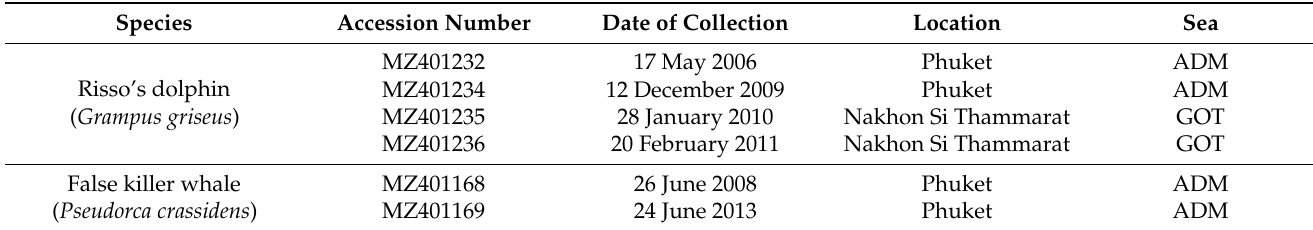
Table 1. Cetacean samples used in this study obtained from Thailand’s territorial